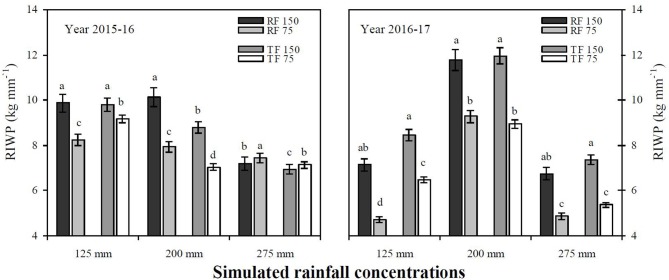
Rainfall irrigation water productivity (RIWP) in 2015–16 and 2016–17. RF150: ridges covered with plastic film mulch and 150 mm deficit irrigation; RF75: ridges covered with plastic film mulch and 75 mm deficit irrigation; TF150: traditional flat planting and 150 mm deficit irrigation; TF75: traditional flat planting and 75 mm deficit irrigation. Three different simulated rainfall intensity 275, 200, and 125 mm were used. Different lowercase letters indicate significant differences at P < 0.05, and the error bars represent the standard error of the mean (n = 3).